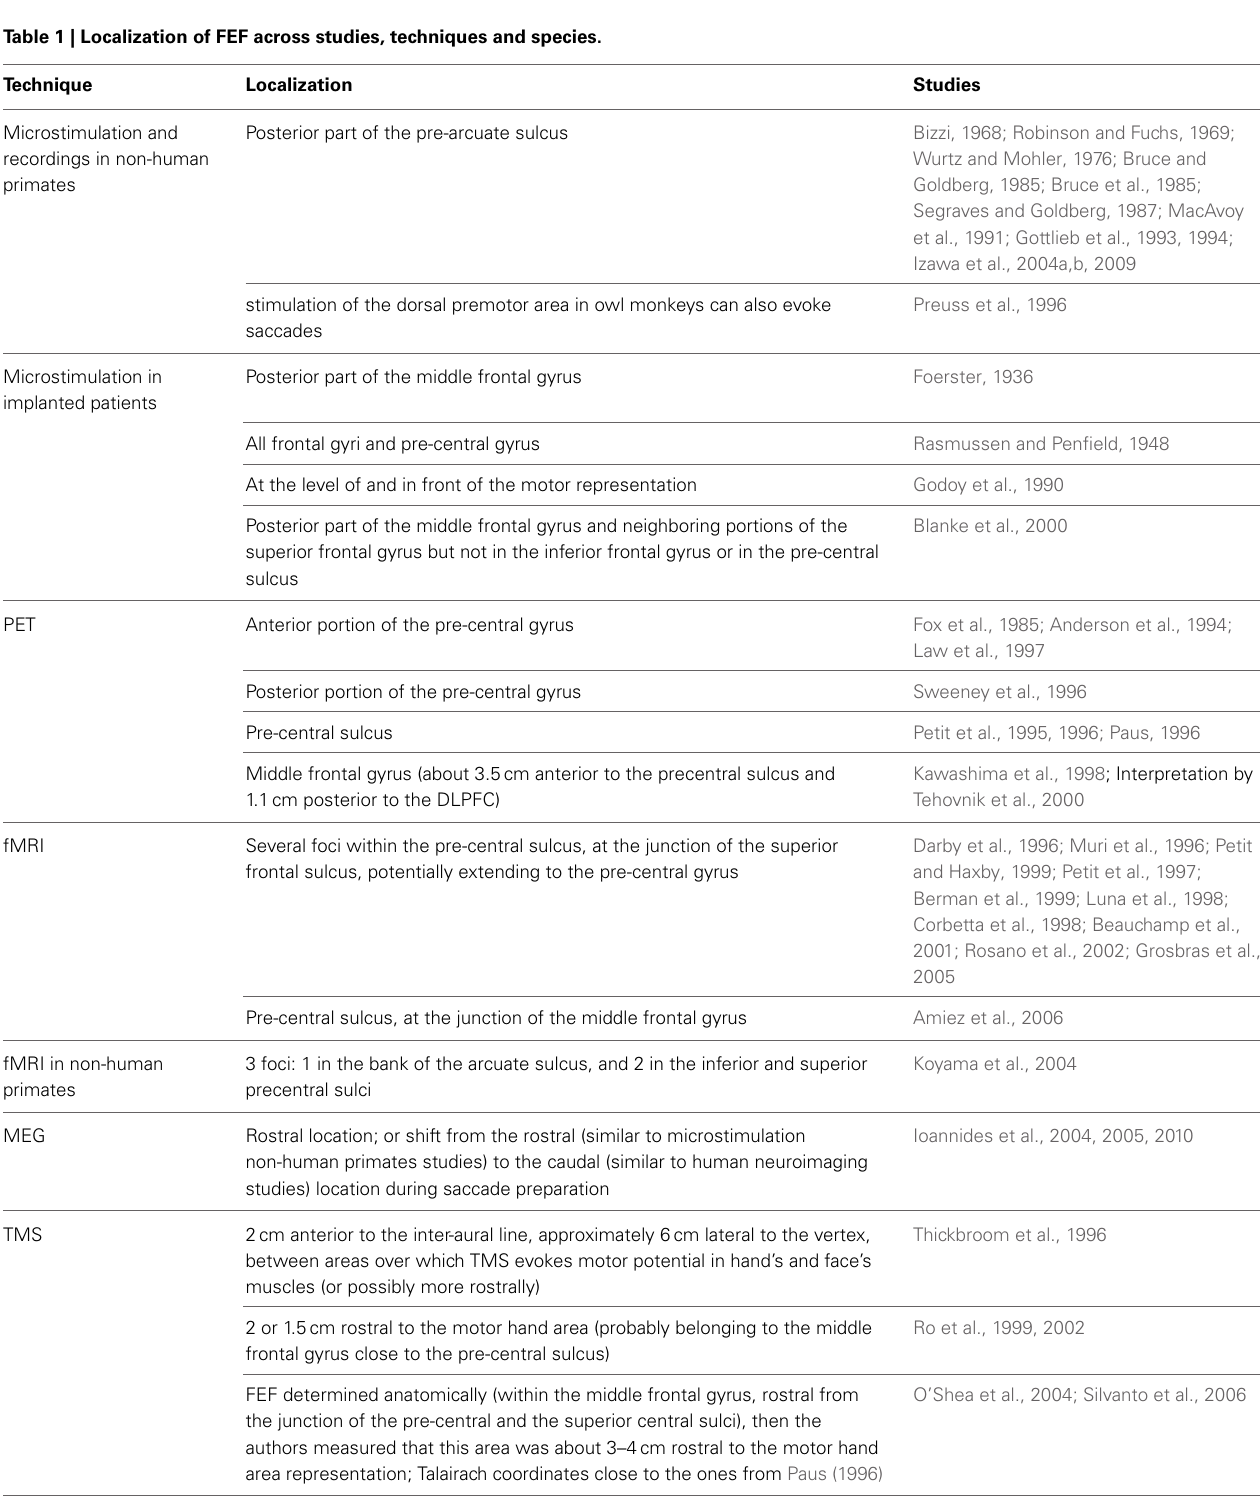
Table 1 | Localization of FEF across studies, techniques and